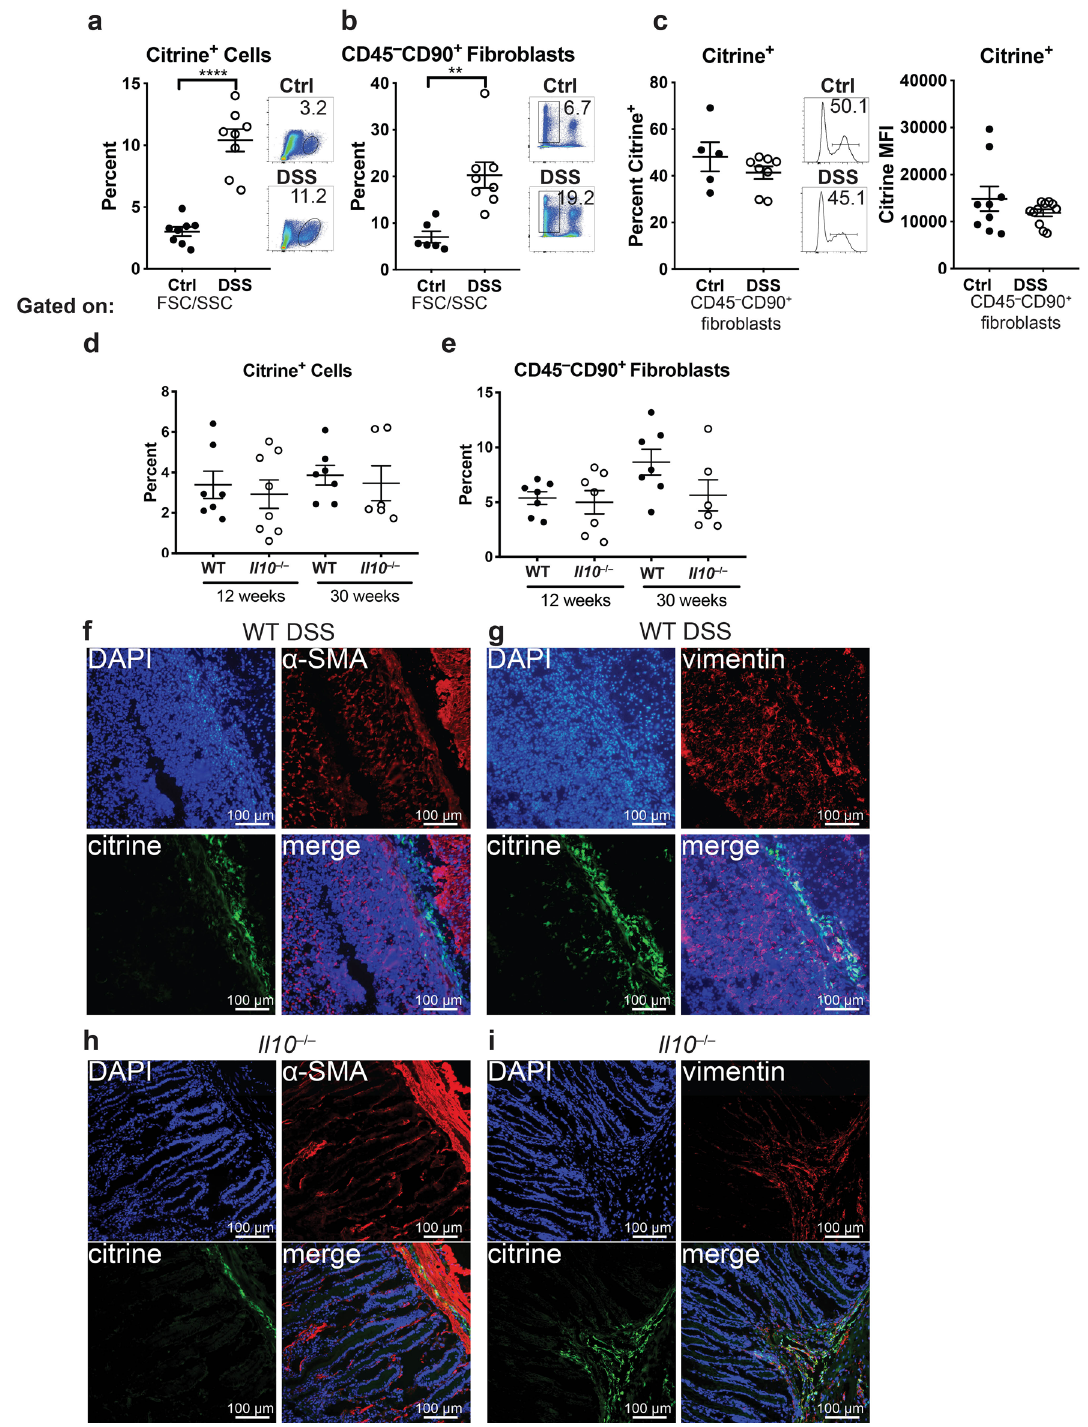
Figure 5. Increased colon mucosal fibroblasts in colitis induced by DSS but not IL-10-deficiency. Comparisons of percent of colon lamina propria cells that are ( A ) citrine + ll33- expressing cells or ( B ) CD45 − CD90 + fibroblasts, and ( C ) percent of lamina propria citrine + ll33- expressing fibroblasts and citrine MFI in unchallenged and DSS-treated Il33 Cit /+ mice. Comparisons of percent of colon lamina propria cells that are ( D ) citrine + ll33- expressing cells or ( E ) CD45 − CD90 + fibroblasts in 12- and 30-week old WT and Il10 −/− mice. Representative immunofluorescent images from DSS-treated Il33 Cit /+ mice ( F ) and ( G ) and Il10 −/− Il33 Cit /+ mice ( H ) and ( I ) N = 5–8 mice/group **p < 0.01, ****p <